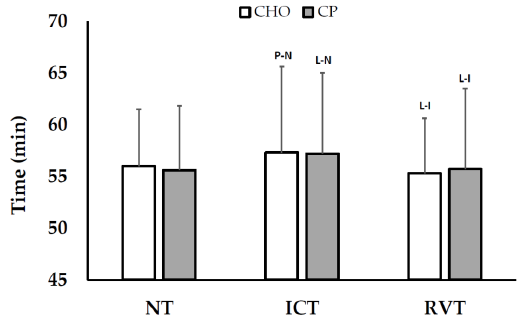
Figure 2. Cycling Performance (Mean ± SD) during Normal, Intensified, and Reduced ‐ Volume